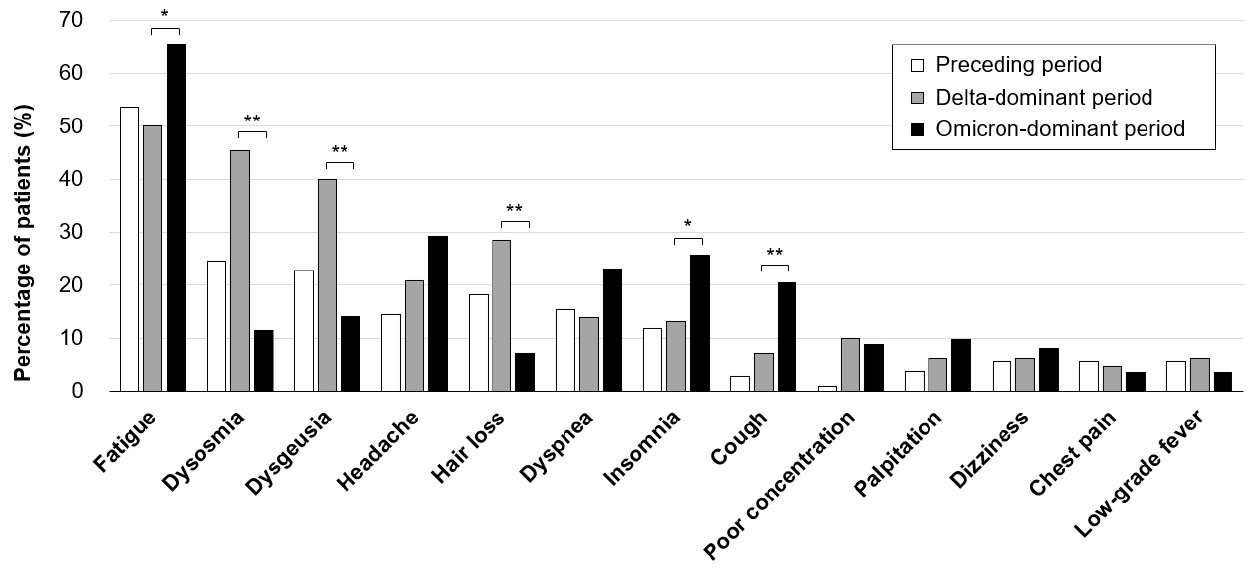
Figure 2. Proportions of long COVID symptoms in patients infected in the preceding, Delta-domi- nant, and Omicron-dominant periods. The percentages of major PCC symptoms in the patients infected during the preceding, Delta-dominant, and Omicron-dominant periods (preceding period: n = 110; Delta-dominant period: n = 130; Omicron-dominant period: n = 113) are shown. The χ 2 test was performed for the Delta- and Omicron-dominant period groups. We regarded * p < 0.05 and ** p < 0.01 as statistically significant differences between the Delta- and Omicron-dominant period groups.